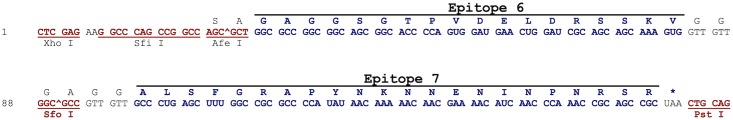
Multiepitope DNA string sequence coding for epitopes detected from the putative PLA2 from M. corallinus.Cysteine codons were exchanged by serine codons to avoid the formation of disulphide bond-mediated protein multimerisation. Epitopes were separated by a six residues linker. Restriction sites (red sequences) were inserted between epitopes to allow further DNA manipulation when required.